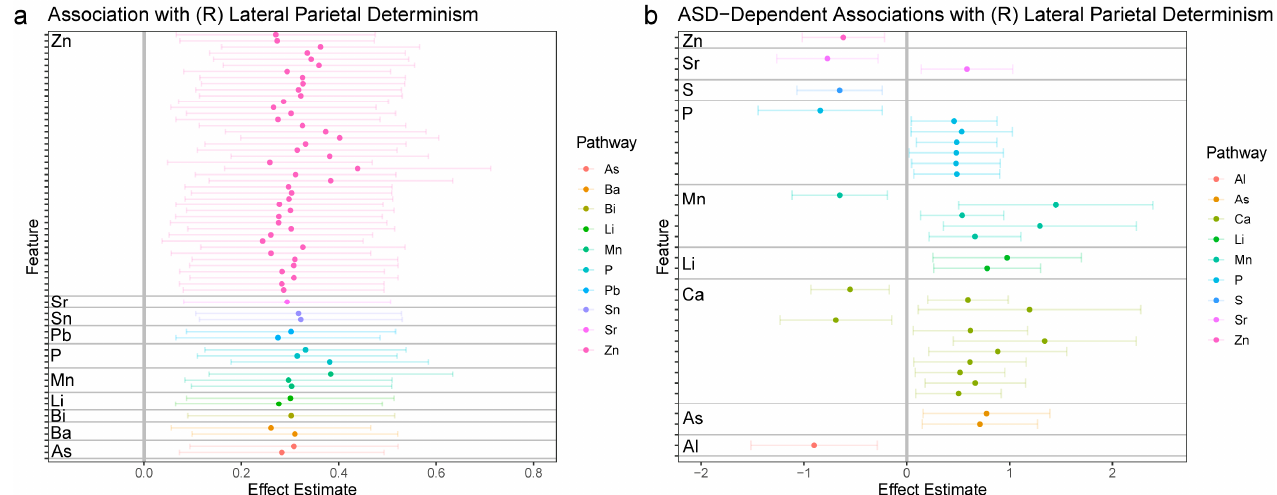
Figure 2. Associations between elemental dynamics and DMN functional connectivity. ( a ) Left panel shows effect estimates for associations between elemental features and determinism in the average DMN signal; only features with significant associations following FDR-adjustment for multiple comparisons are shown. ( b ) Right panel shows effect estimates for the interaction between autism and features of elemental dynamics; features with significant associations following FDR-adjust- ment for multiple comparisons are shown. The magnitude of effect estimates in essence depicts the difference in a given feature between participants with autism and control participants.